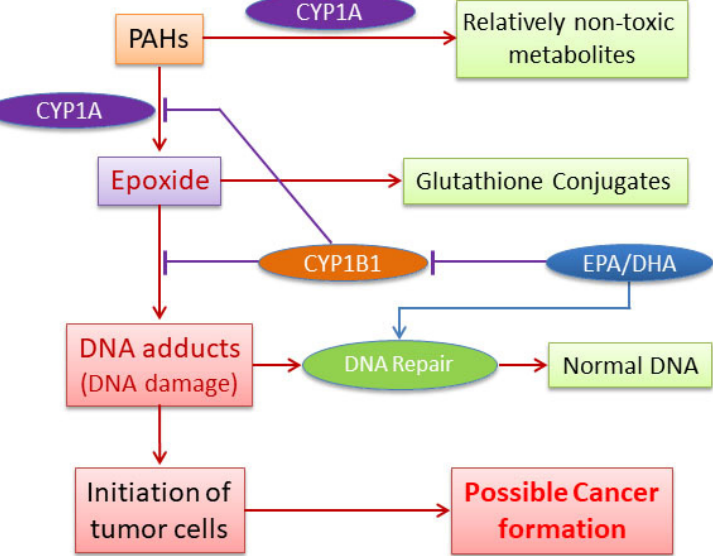
Figure 9. Proposed mechanisms of attenuation of PAH-DNA adducts and tumor formation by omega-3 fatty acids EPA/DHA.